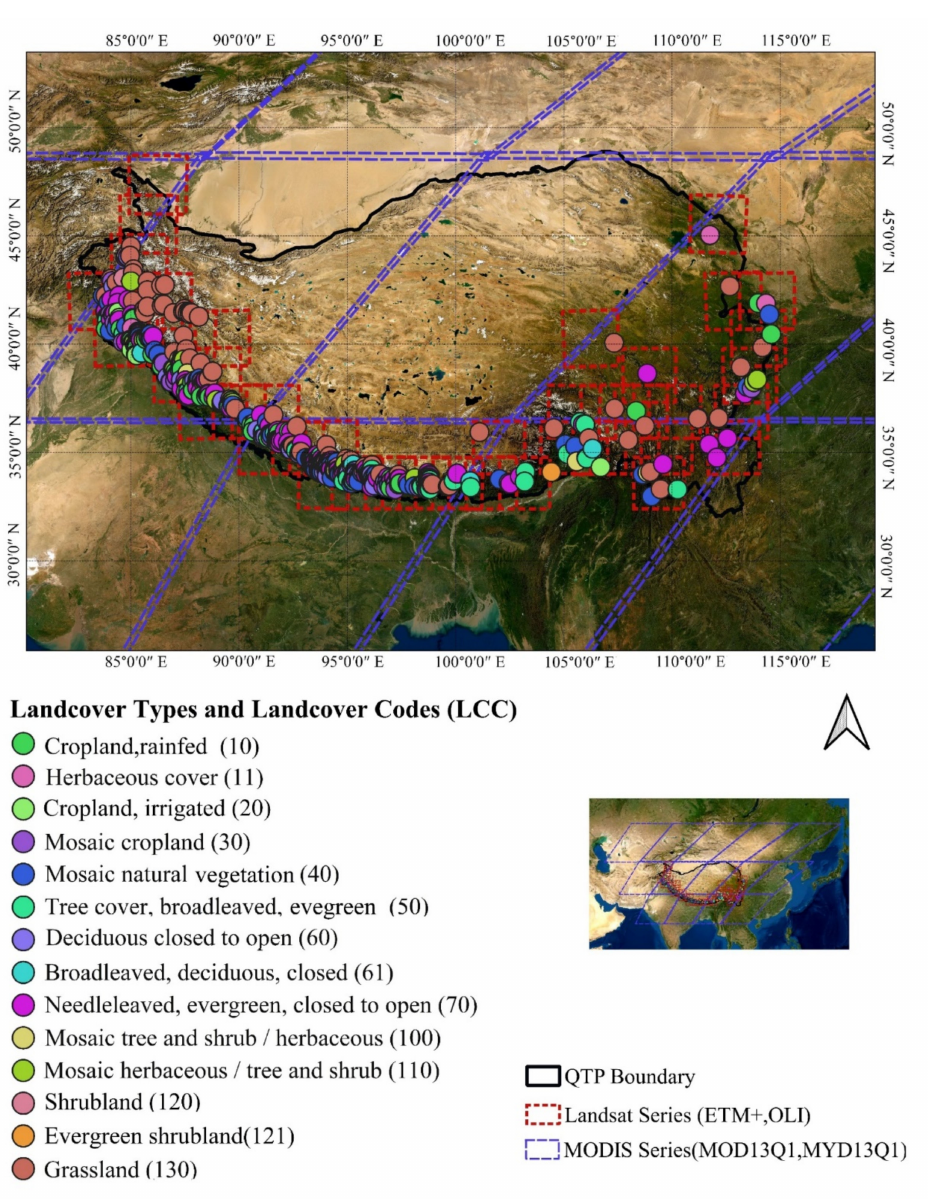
Figure 1. Location of the Qinghai-Tibetan Plateau (QTP), with the 618 landslide locations and their associated landcover classes (14 natural landcover classes were identified in the study area). Landsat and MODIS satellite scenes covering the study area are also